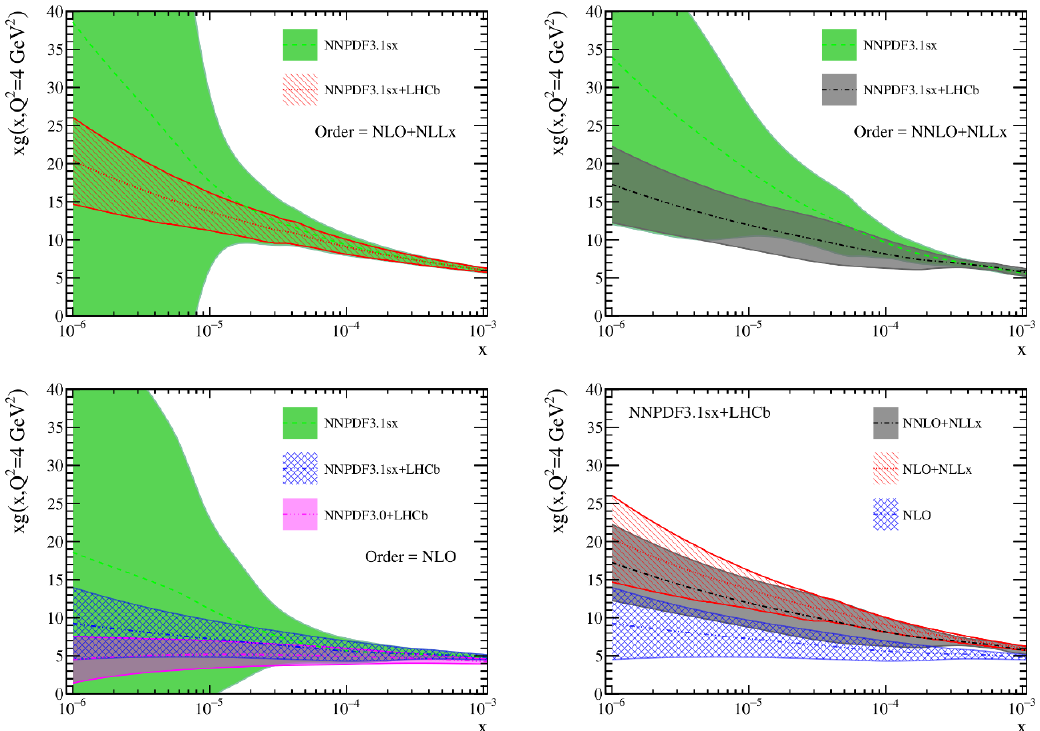
Figure 8 . Comparison of the gluon PDF at Q 2 = 4 GeV 2 from the di(cid:11)erent NNPDF3.1sx prior sets with the corresponding results once the LHCb D -meson cross-sections have been included in the (cid:12)t. The results are shown for three di(cid:11)erent theoretical settings: using resummed NLO+NLL x and NNLO+NLL x theory (upper plots) and using (cid:12)xed-order NLO theory (lower-left plot). In addition, a comparison of the (cid:12)t results obtained with di(cid:11)erent theory settings is also shown in the lower right plot. For completeness, in the NLO comparison we also show the NNPDF3.0+LHCb results of ref.